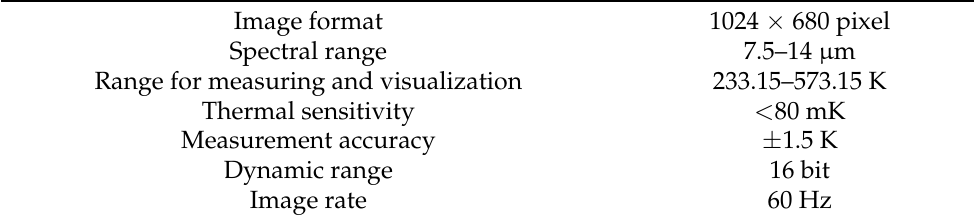
Figure 2. Domain of the working fluid chamber covered by the IR-camera ( left ). The thick magenta line shows the azimuthal sections along which data were collected to obtain the Hovmoeller plot ( right ). In this example, 1 h of data are shown. Waves propagate counterclockwise. Color code: dark blue = 22.5 ◦ C; dark red = 24.4 ◦ C. Table 2. Infrared camera’s technical specifications. The infrared camera used was from Jenoptik, module IR-TCM 640. The software was the IRBIS package developed by InfraTec GmbH, Dres- den,